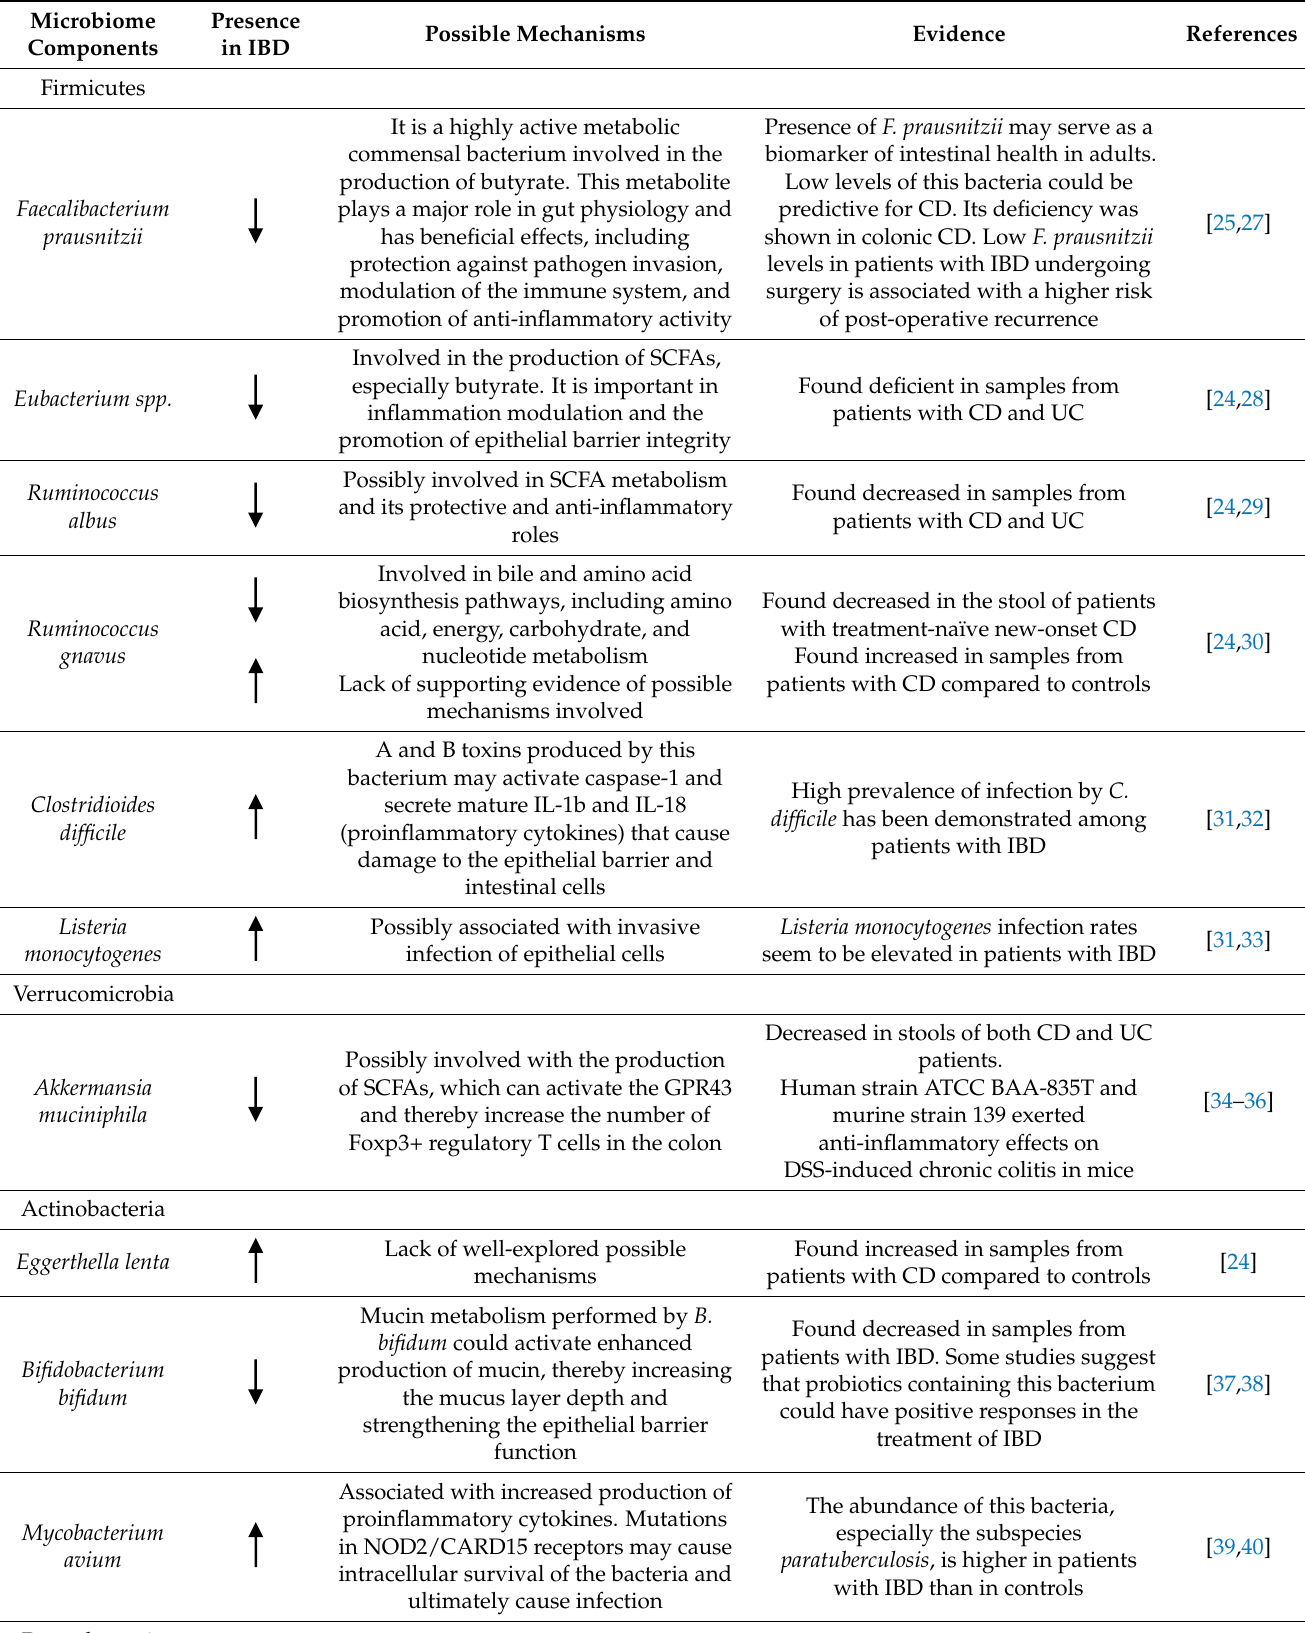
Table 1. Association between the gut microbiome and inflammatory bowel